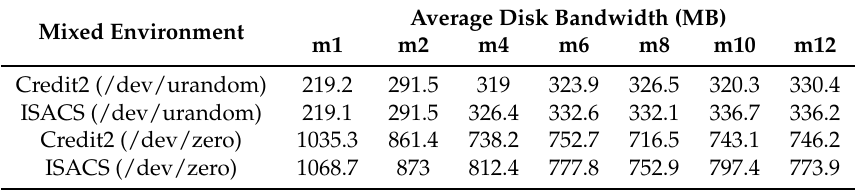
Table 8. Average disk bandwidth according to the VM configuration based on Figure